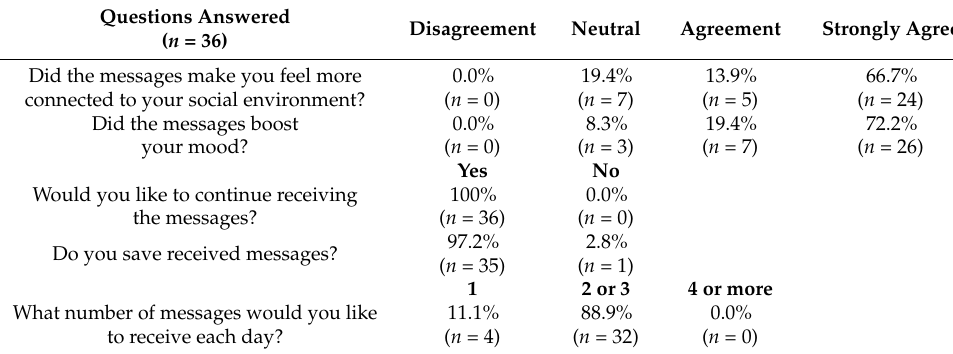
Table 3. Final questionnaire on text messages